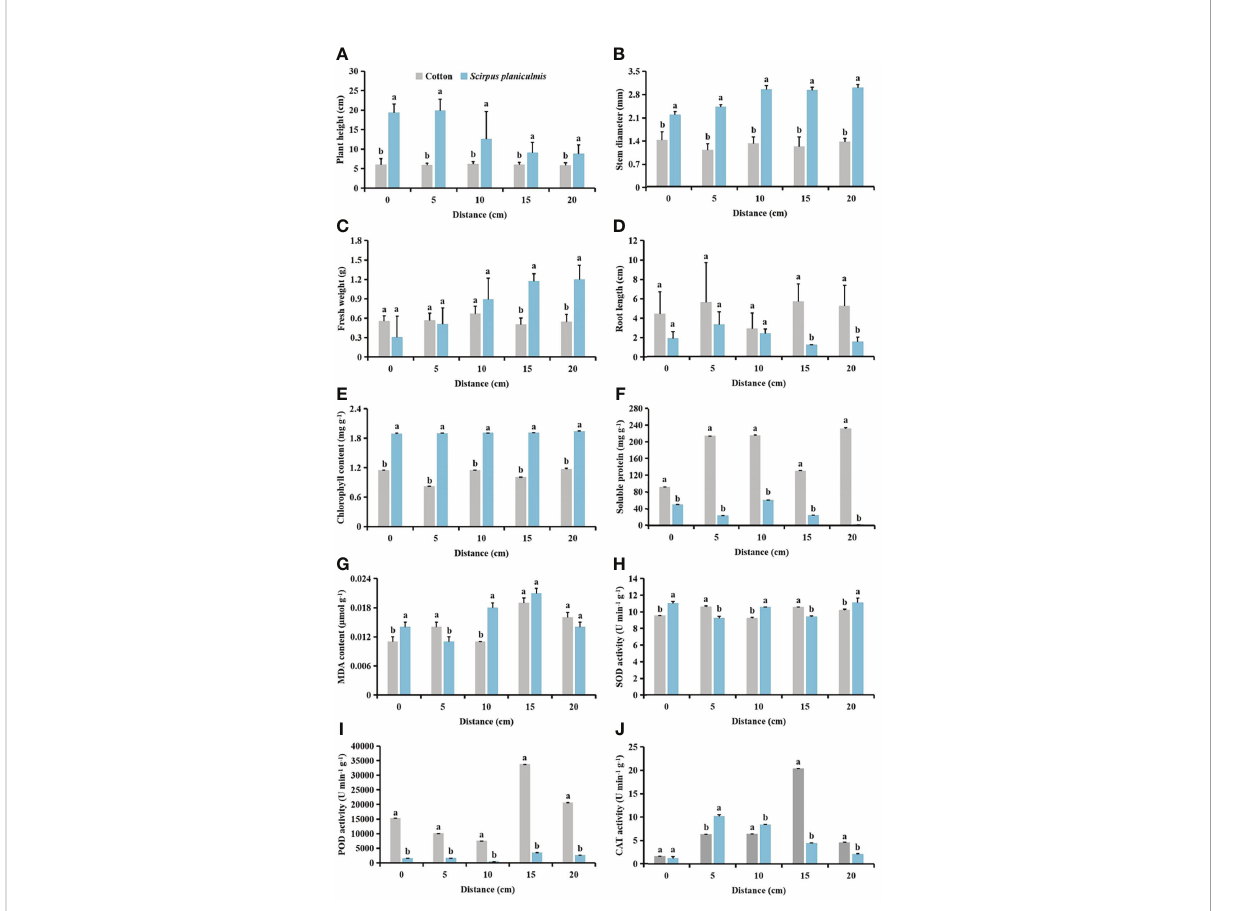
FIGURE 10 Under different spatial distribution of Scirpus planiculmis , the (A) plant height, (B) stem diameter, (C) fresh weight, (D) root length, (E) chlorophyll, (F) soluble protein and (G) malondialdehyde (MDA) content, and (H) superoxide dismutase (SOD). (I) peroxidase (POD) and (J) catalase (CAT) activities in cotton and S. planiculmis . The mean value ± standard data were presented in the fi gure. Different alphabetical letters indicate the signi fi cant differences between cotton and S. planiculmis ( p